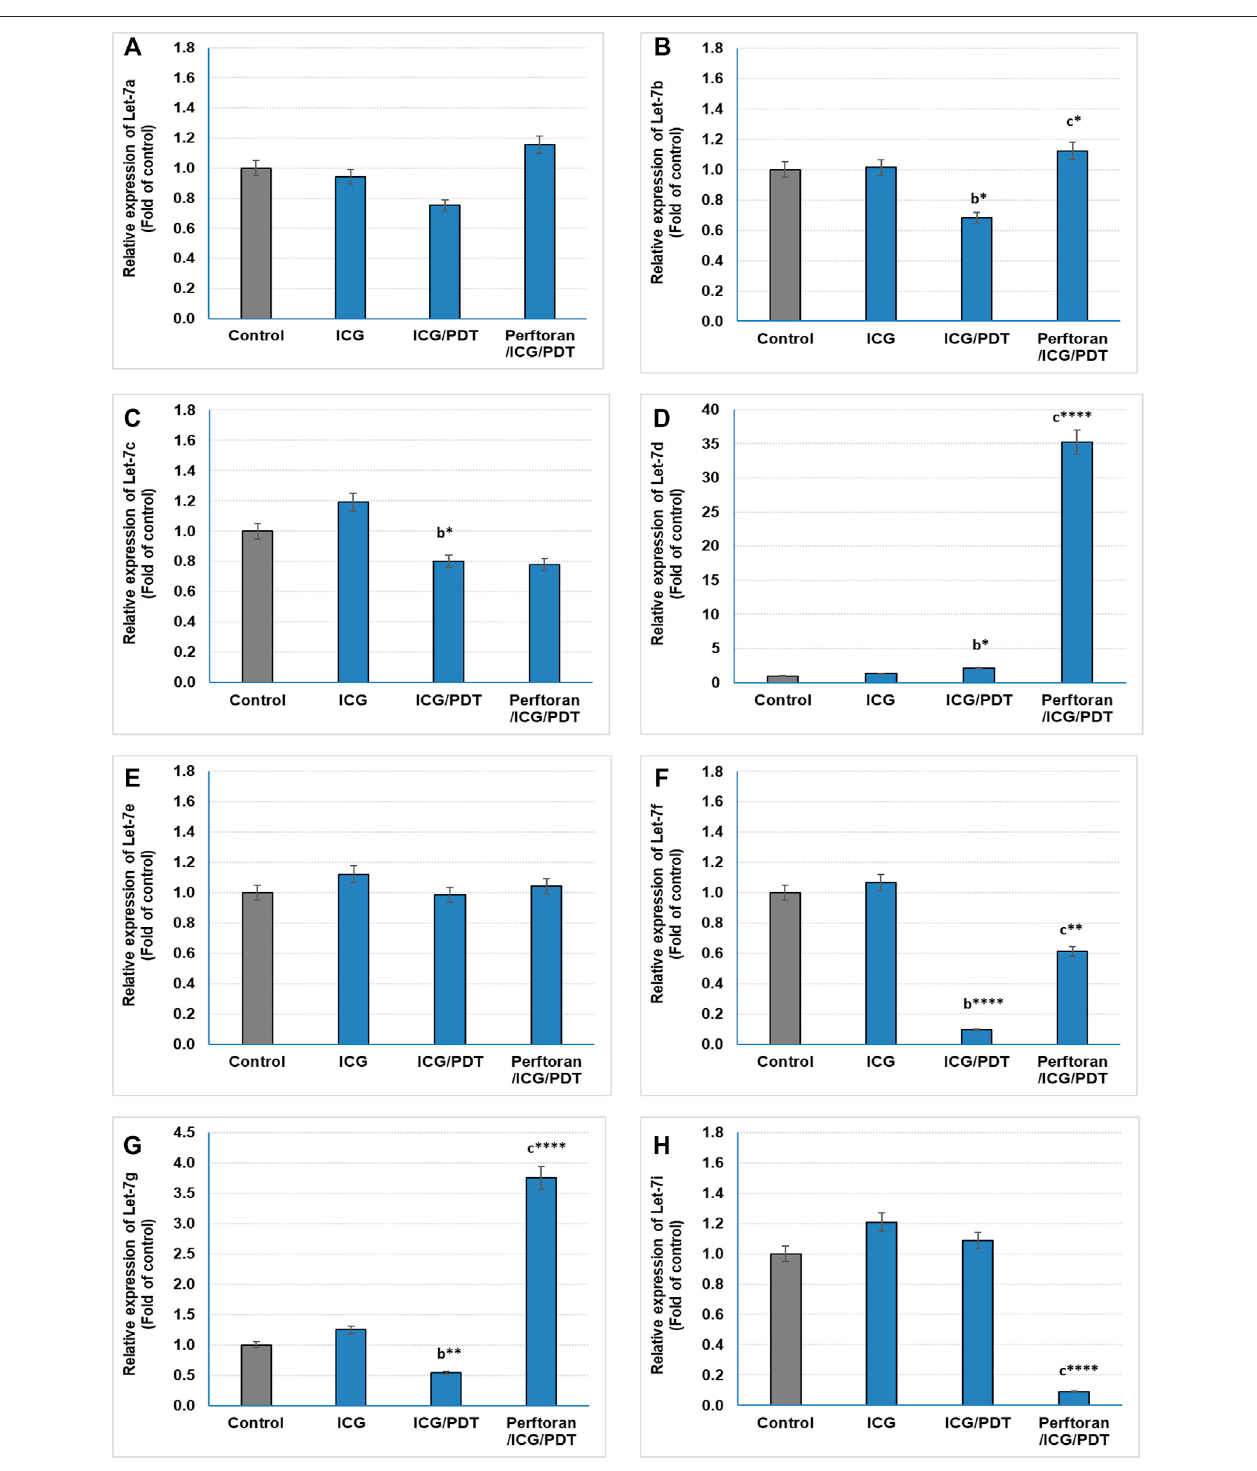
FIGURE 2 | Expression of tumor suppressor miRNAs (Let-7 family; (A – H) ): The relative expression of miRNAs was estimated by qRT-PCR. The results are expressed as fold of control. The results were compared to those of a control cells, b ICG-treated cells, and c ICG/PDT-treated cells; * p < 0.05, ** p < 0.01, *** p < 0.001, and **** p <